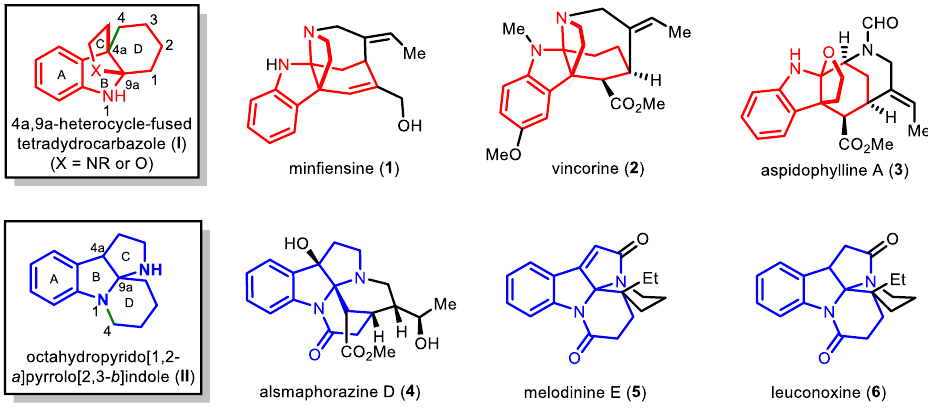
Figure 1. Representative indole alkaloids containing the tetracyclic skeleton I and II .